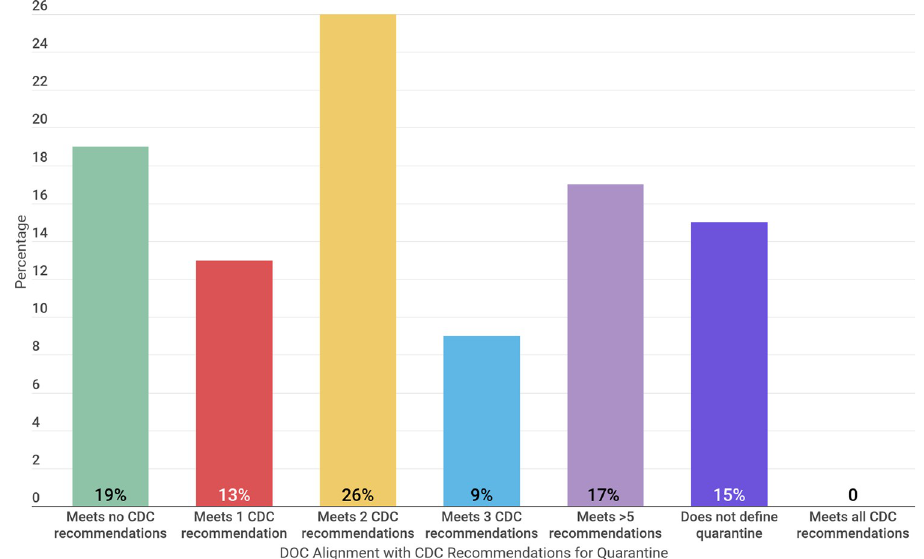
Fig 1. Percentage of DOCs that align with CDC recommendations according to DOC published definitions of